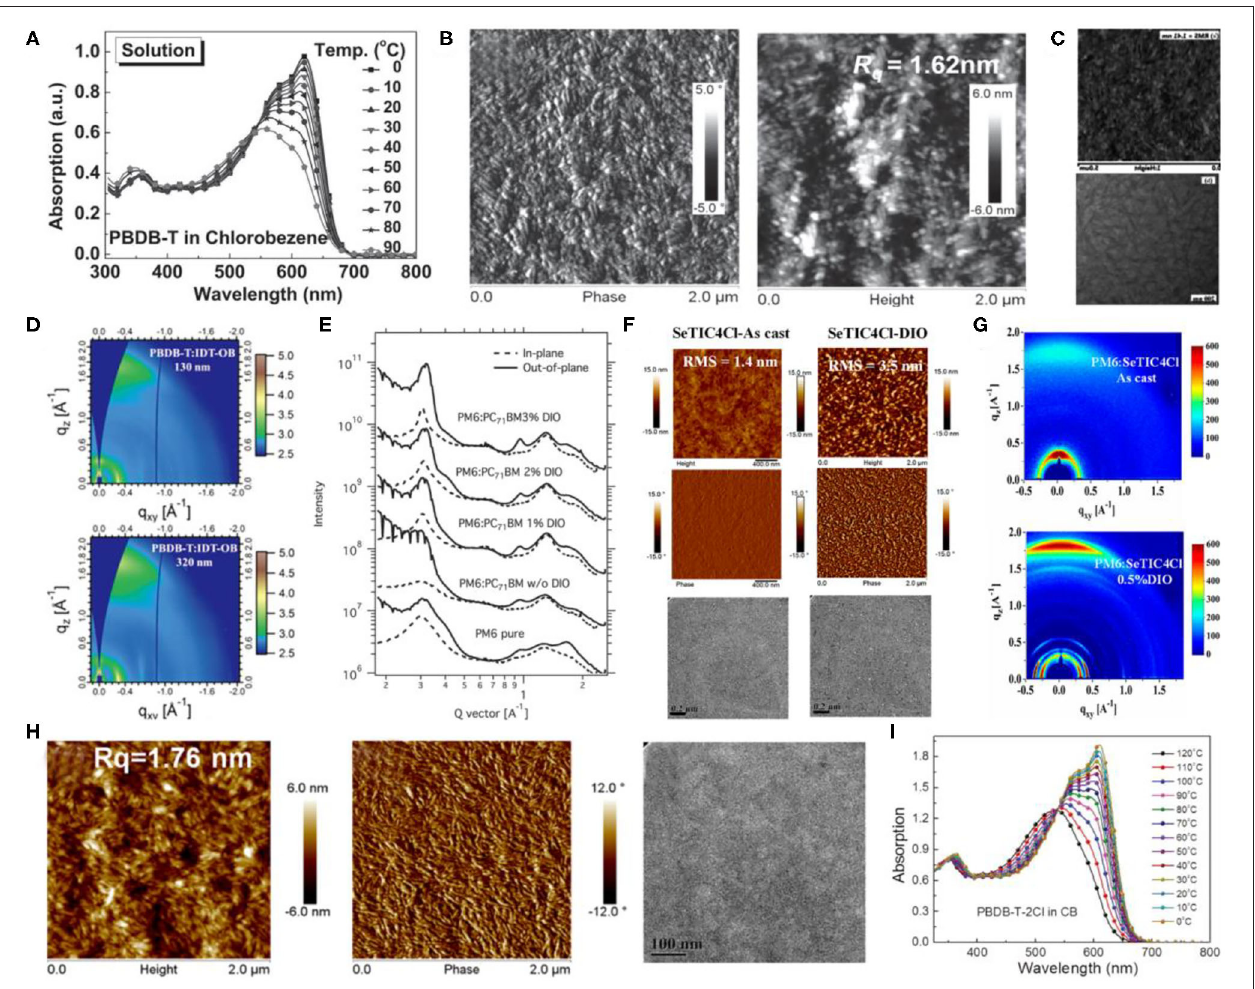
FIGURE 8 | (A) Temperature-dependent absorption spectra of the polymer PBDB-T in chlorobenzene solution. Copyright 2016, Wiley-VCH. (B) AFM phase images (left) and AFM height images (right) of PBDB-T:ITIC film. Copyright 2016, Wiley-VCH. (C) AFM (top) and TEM (bottom) images of PBDB-T:IDT-OB film. Copyright 2017, Wiley-VCH. (D) 2D GIWAXS scattering patterns PBDB-T:IDT-OB blend films with different thickness of active layers. Copyright 2017, Wiley-VCH. (E) GIXD profiles for the pure film of PM6 and blend films of PM6:PC 71 BM (1:1.2, wt/wt) with different amounts of DIO. Copyright 2015, Wiley-VCH. (F) AFM height (top), phase (middle) and TEM (bottom) images of as-cast SeTIC4Cl/PM6 blend films (left) and DIO-treated SeTIC4Cl/PM6 blend films (right). Copyright 2018, American Chemical Society. (G) GIXD patterns of as-cast SeTIC4Cl/PM6 blend films and DIO-treated SeTIC4Cl/PM6 blend films. Copyright 2018, American Chemical Society. (H) Morphology images of the blend films: AFM height (left), phase (middle) images, and TEM image (right) of PBDB-T-SF:IT-4F blend film. Copyright 2017, American Chemical Society. (I) TD-Abs spectra of the solutions of PBDB-T-2Cl in CB as the temperature decreased from 120 to 0 ◦ C. Copyright 2018,